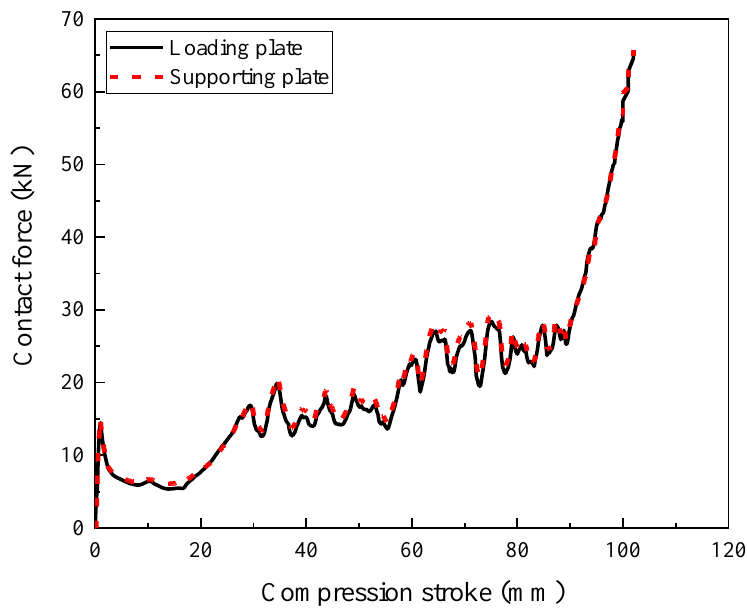
Figure 18. The contact forces between the composite and the loading or supporting plates ( t = 0.2:0.2:0.2 and ρ = 408:575:848, 1 m/s).